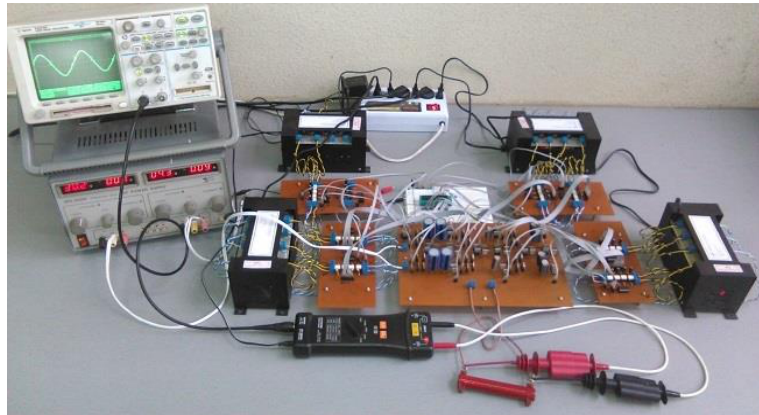
Figure 9. Laboratory test setup of a 25-level inverter of the presented SCMLI.